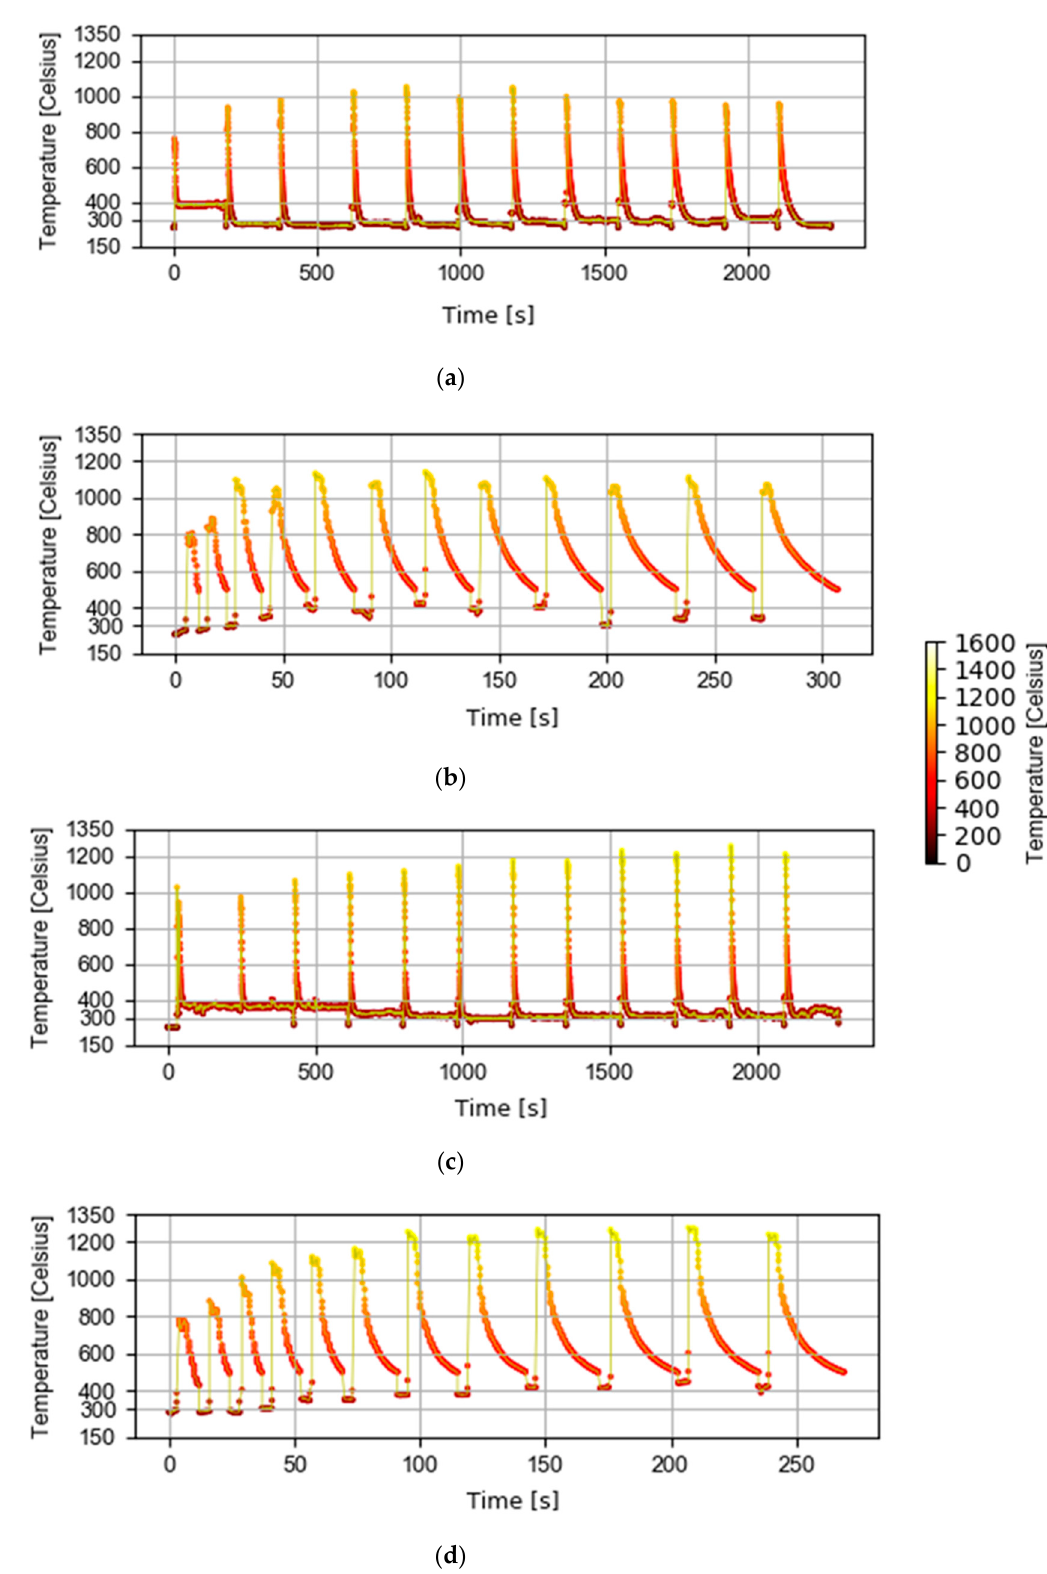
Figure 6. Surface temperature on the interlayer cooling time with strategies ( a ) B_ICS, ( b ) B_COS, ( c ) C_ICS and ( d ) C_COS. C_ICS and ( d )